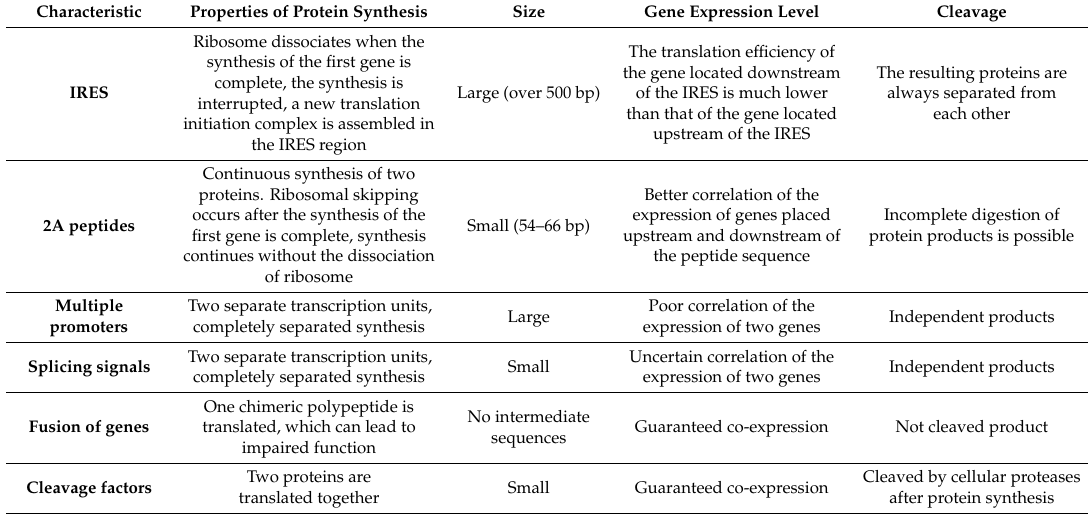
Table 1. Comparison of the characteristics of various strategies for the expression of multiple